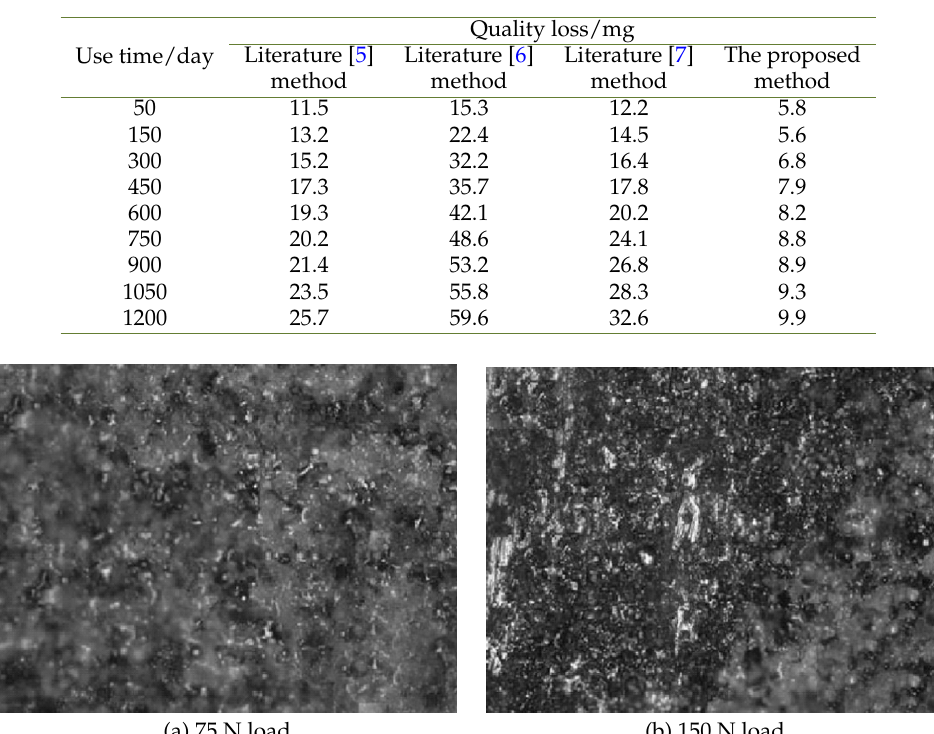
Fig. 6. Wear morphology of CoCrAlY-Al 2 O 3 coating. Table 1. Wear quality loss under different methods.